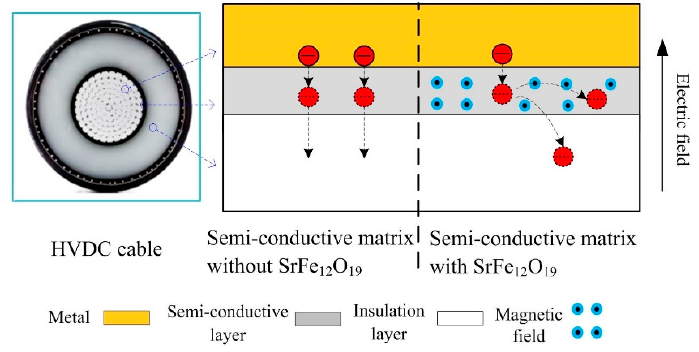
= high voltage direct